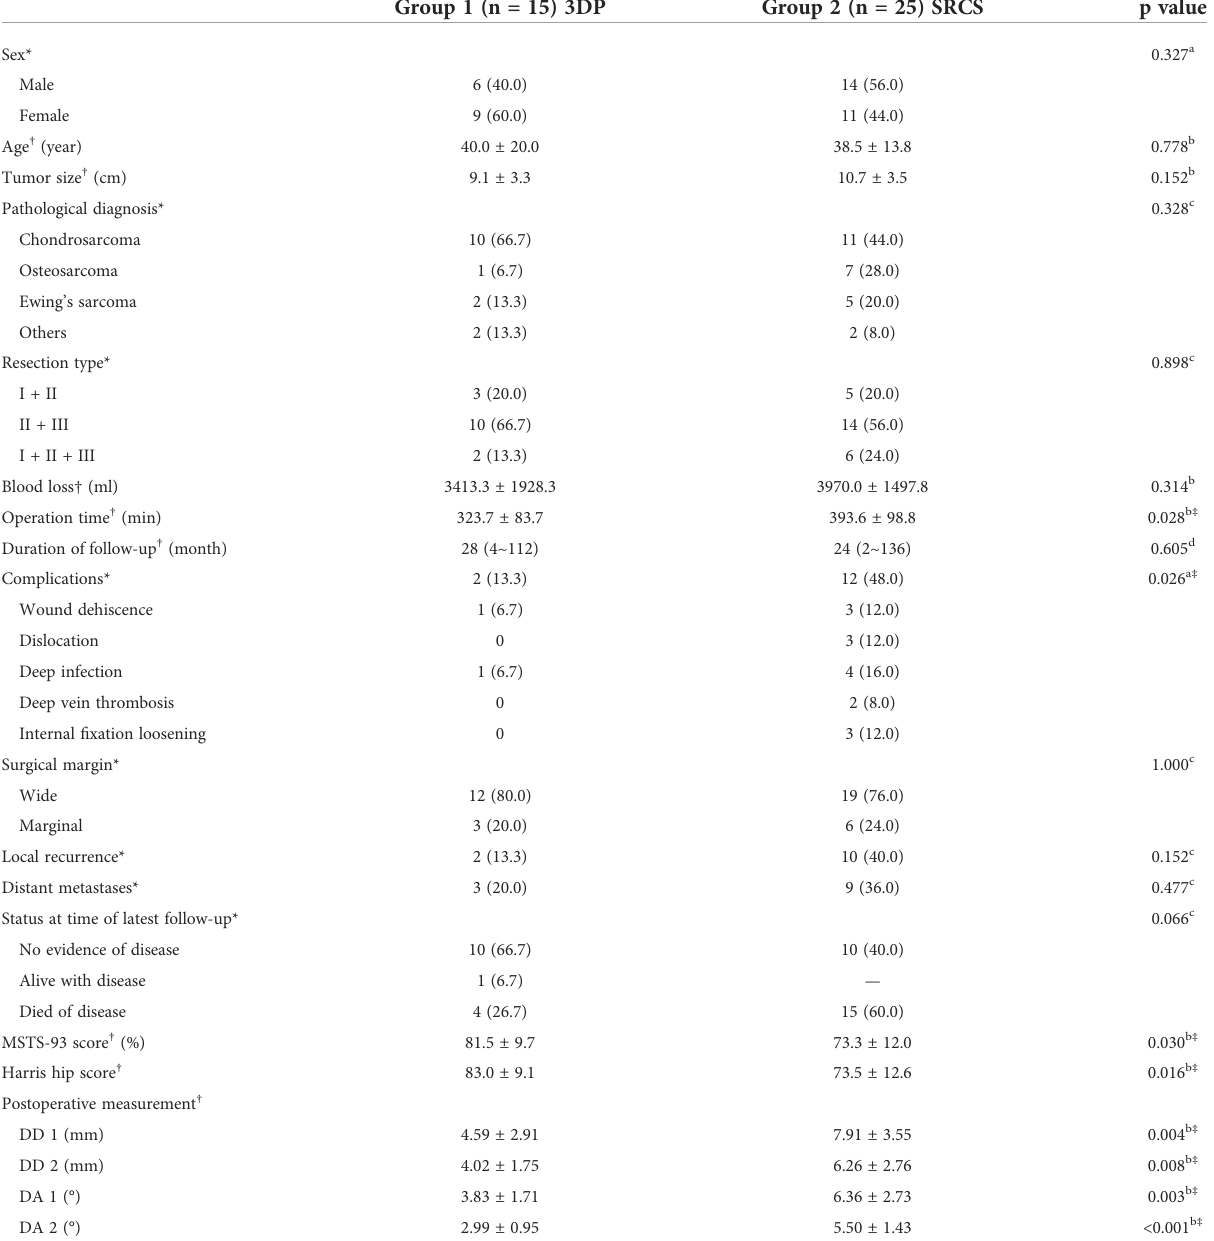
TABLE 3 Baseline, operative, and follow-up data of patients with pelvic tumor resection and